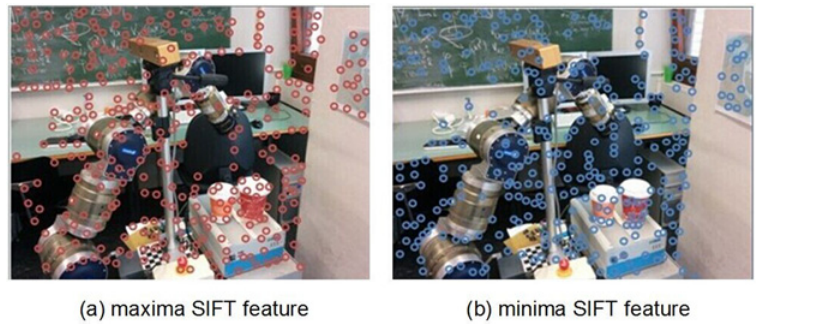
Fig 1. The Maxima and Minima SIFT features extracted from the same image.